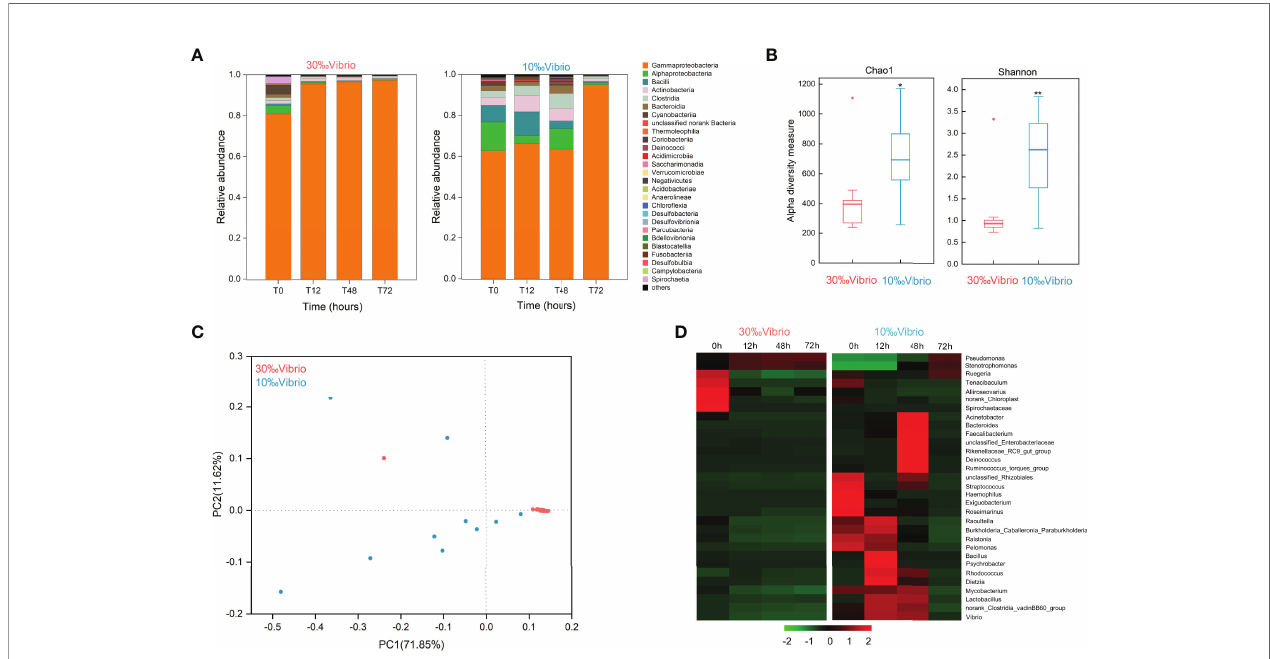
FIGURE 3 | Micro fl ora changes in V. alginolyticus infected oysters exposed to salinity of 10 ‰ and 30 ‰ . (A) Relative proportion of bacteria (class level) for “ 10 ‰ Vibrio ” and “ 30 ‰ Vibrio ” oysters. T0, T12, T48 and T72 indicated different sampling time-points (in hours) during the experiment. (B) Temporal dynamics of alpha diversity in V. alginolyticus infected oysters at different salinity (10 ‰ and 30 ‰ ). Chao1 and Shannon ’ s H index for “ 30 ‰ Vibrio ” and “ 10 ‰ Vibrio ” oysters. Asterisk indicated P < 0.05. (C) Principal coordinate analysis (PCoA) plot of the Bray-Curtis dissimilarity matrix of the micro fl ora comparing “ 10 ‰ Vibrio ” and “ 30 ‰ Vibrio ” oysters. The axes of the PCoA represent the two synthetic variables that explained the most variation of the dataset. (D) The abundance of each bacteria at the genus level in “ 10 ‰ Vibrio ” and “ 30 ‰ Vibrio ” oysters. Only genera with a relative proportion >0.5% in at least one sample are shown. The abundance of each type of bacteria in “ 10 ‰ Vibrio ” and “ 30 ‰ Vibrio ” oysters at the genus level during the V. alginolyticus infection. Green colour (smaller Log10 index) indicated lower abundance. Red colour (larger Log10 index) represented higher